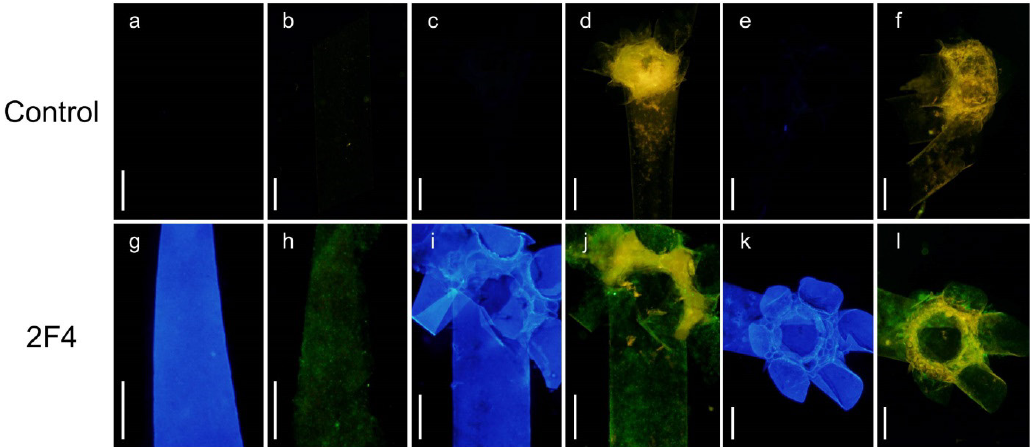
Fig. 3: Fluorescent micrographs of Chara corallina explants: internodes (a, b, g, h), longitudinal sections of nodes (c, d, i, j) and and cross sections of nodes (e, f, k, l); stained with calcofluor white (g, i, k) and immunolabelled with 2F4 (h, j, l); for control (a-f) the incubation without calcoflour white or primary and secondary antibodies; bars = 0.5 mm.